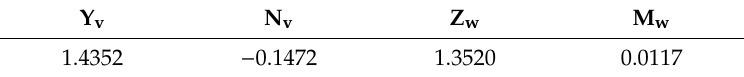
Table 7. Solving cases of rotational derivatives.